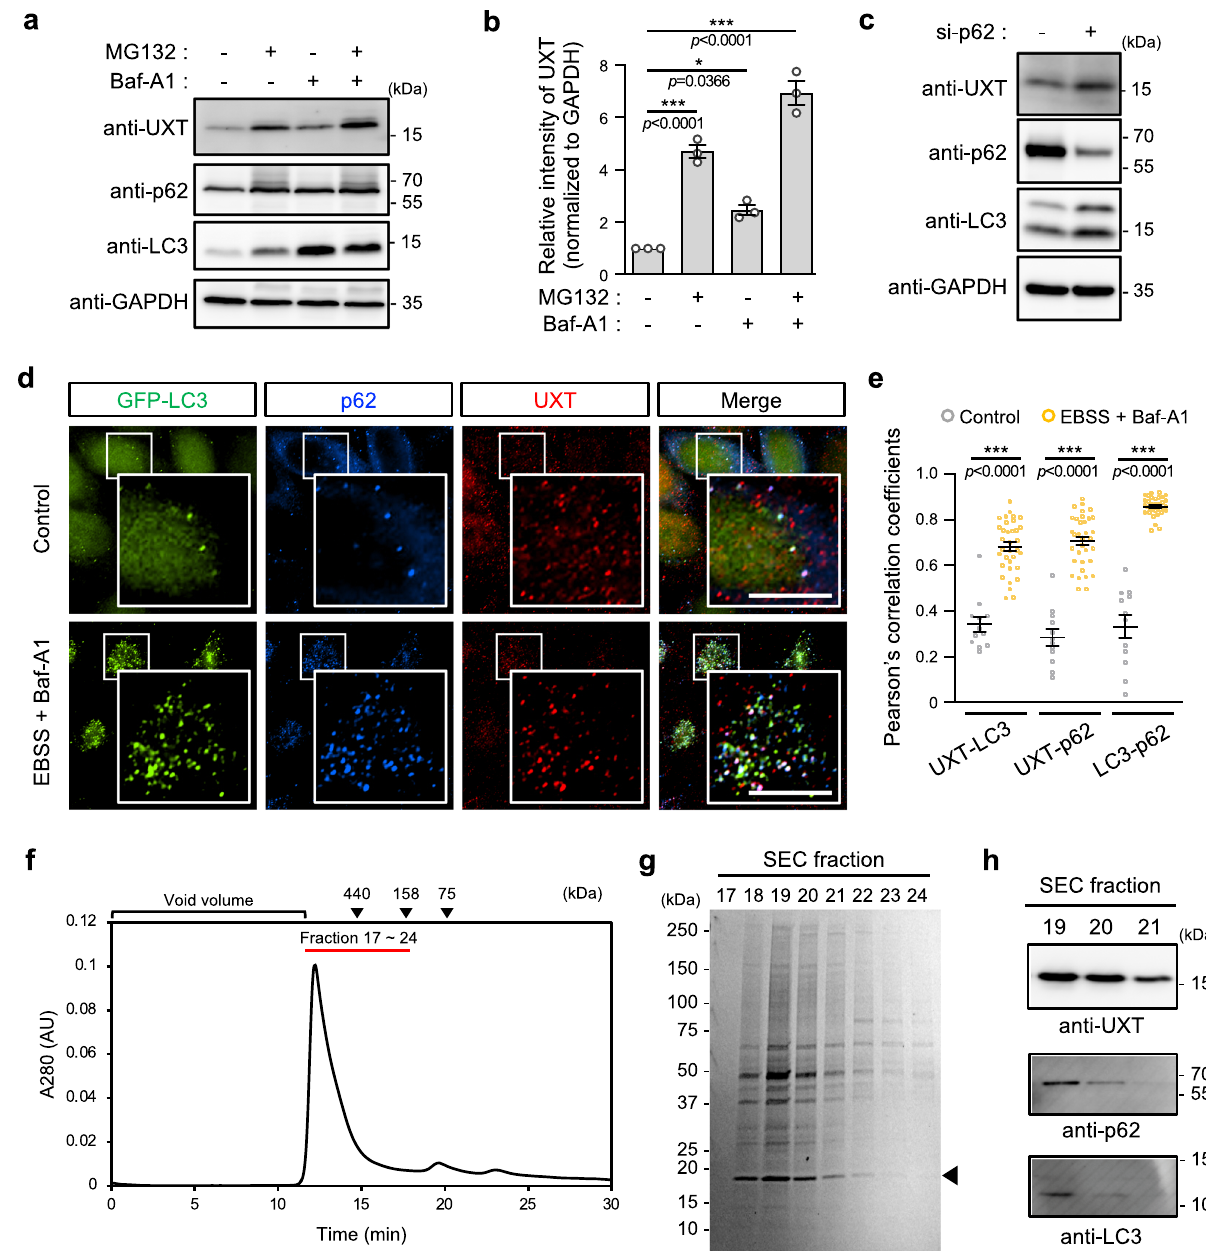
Fig. 3 UXT and p62 cooperate and are involved in autophagy. a HeLa cells were treated with 2.5 μ M MG132 and/or 50 nM ba fi lomycin A1 (Baf-A1) for 12 h, and the whole-cell lysates were subjected to a western blot analysis. b Band intensities of UXT in each condition were normalized to that of GAPDH, and their relative intensities against non-treated condition are shown as bar graphs ( n = 3, mean ± SEM). * p < 0.05; ** p < 0.01; *** p < 0.001 (one-way ANOVA using Bonferroni ’ s multiple comparison test). c HeLa cells were transfected with p62-siRNA and then whole-cell lysates were subjected to a western blot analysis. d HeLa cells stably expressing GFP-LC3 were starved of amino acids using EBSS media, and this was followed by inhibition of the autophagic fl ux by treatment with 50 nM Baf-A1 for 4 h. The localization of GFP-LC3 (green), p62 (blue), and UXT (red) were analyzed by immunocytochemistry, using anti-p62 and anti-UXT as primary antibodies, and anti-rabbit IgG-Alexa-350 and anti-mouse IgG-TRITC as secondary antibodies. Scale bar, 10 μ m. e Pearson ’ s correlation coef fi cients between each protein were shown as scatter plots ( n = 12 and 34 cells for control and EBSS + Baf-A1, respectively, mean ± SEM). *** p < 0.001 (two-sided Mann – Whitney test). f UXT-eYFP-10×His construct was transfected into HEK293E cells, and the protein puri fi ed using a Ni-NTA column was treated with His-tagged HRV3C protease to cleave the region between UXT and eYFP. Resulting reaction was passed through the second Ni-NTA column and further separated by size-exclusion chromatography (SEC). g Coomassie blue-stained SDS – PAGE gel pro fi le of UXT- containing SEC fractions in f is shown. Arrowhead indicates UXT. h The SEC fractions were further analyzed with western blot using anti-UXT, anti-p62, and anti-LC3